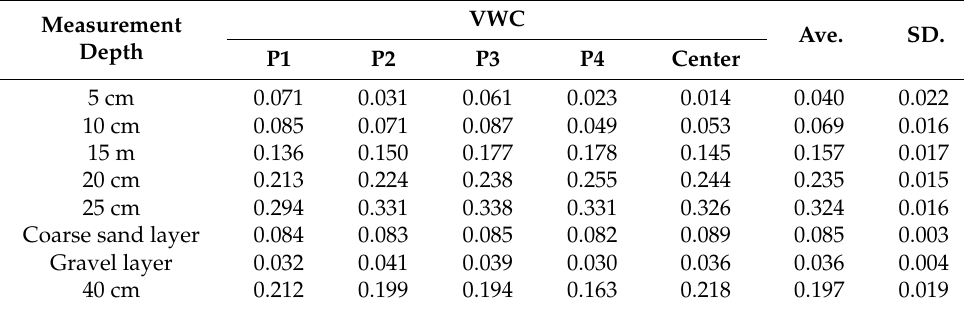
Figure 4. Soil water dynamics in the pot experiment. S1–S6 indicate soil water contents measured using the soil moisture sensors in the pot experiment, while Obs1–Obs6 show corresponding soil water contents simulated by HYDRUS (2D/3D) using the optimized soil hydraulic parameters. Table 4. VWC distribution measured at the end of the pot